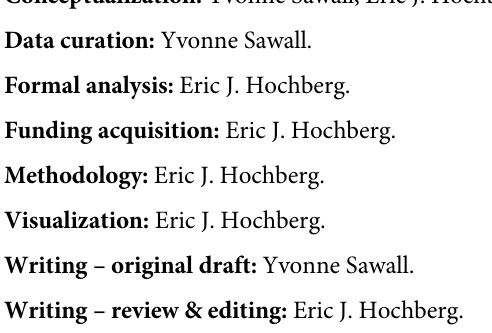
for use in each spe- max